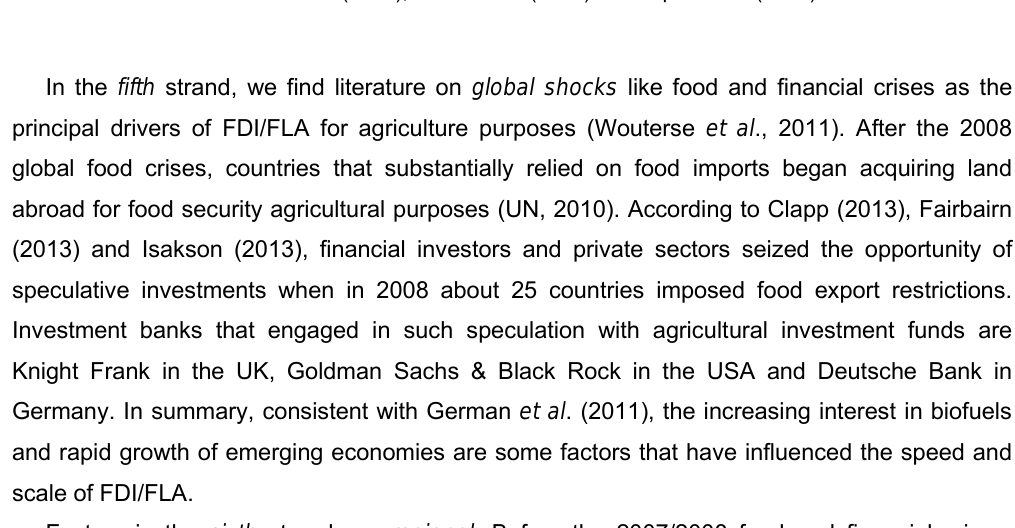
GDP per capita growth (annual %)